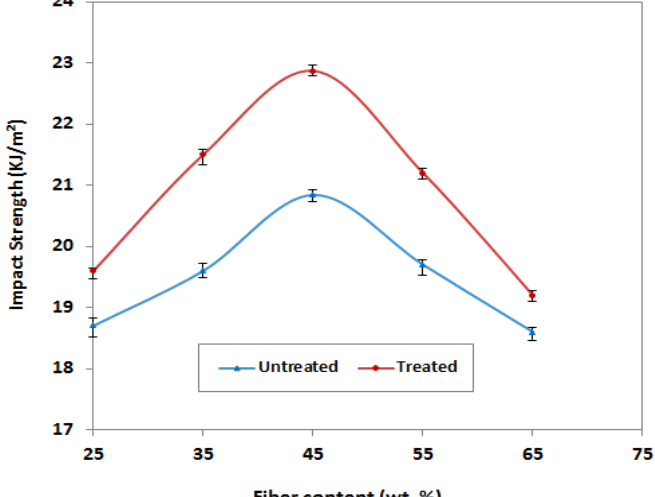
Figure 8: Comparative impact strength (charpy) of the resultant composites with respect to fiber